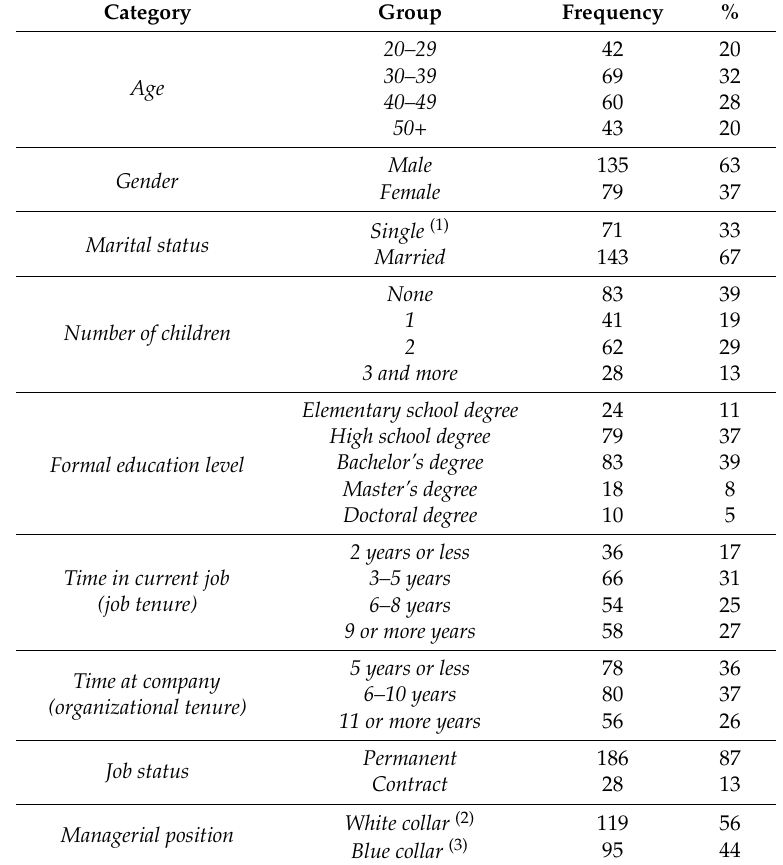
Table 5. Demographics of respondents ( N:214